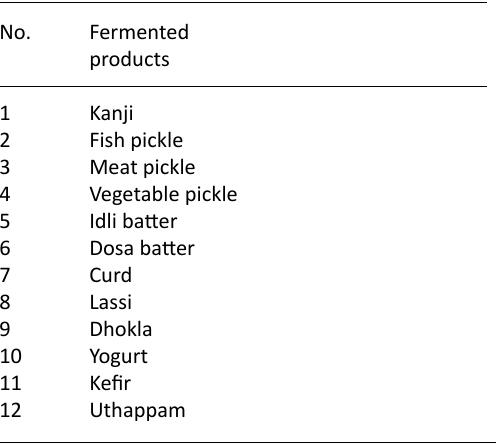
Tabel 1. List of fermented foods screened forproduction of